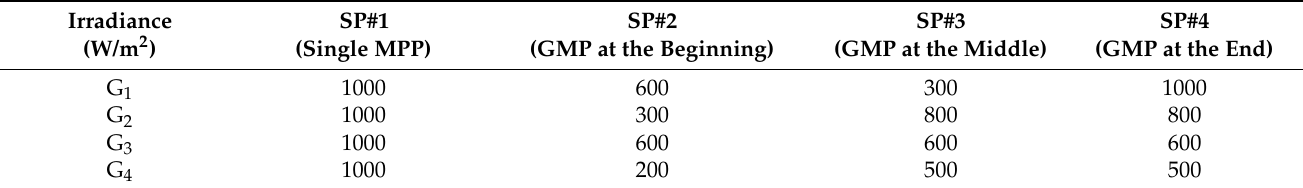
Table 1. Four shading patterns with four different GMP under